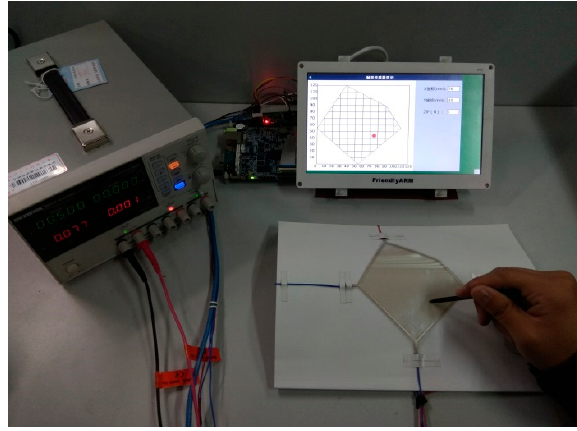
Figure 19. Position detection on the curved surface.